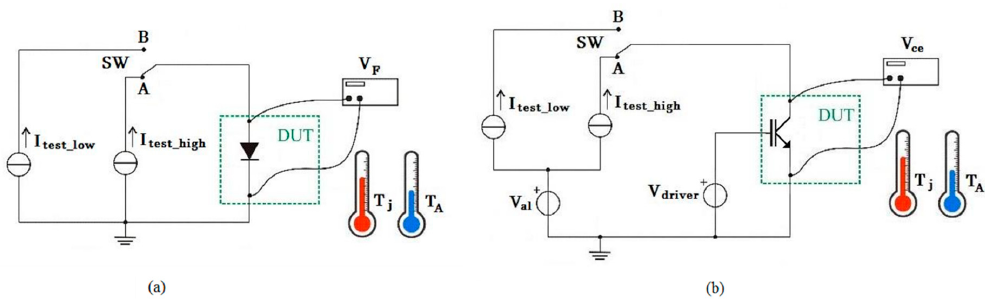
Figure 3. Diode ( a ) and Insulated Gate Bipolar Transistor (IGBT) ( b ) characterization circuits.